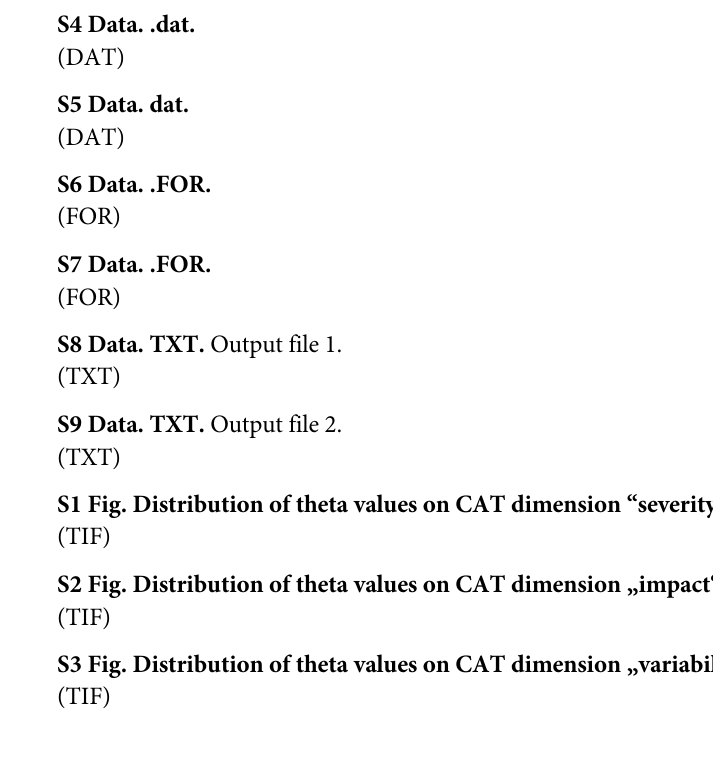
S1 Fig. Distribution of theta values on CAT dimension “ severity ” . S2 Fig. Distribution of theta values on CAT dimension „ impact “ . S3 Fig. Distribution of theta values on CAT dimension „ variability “